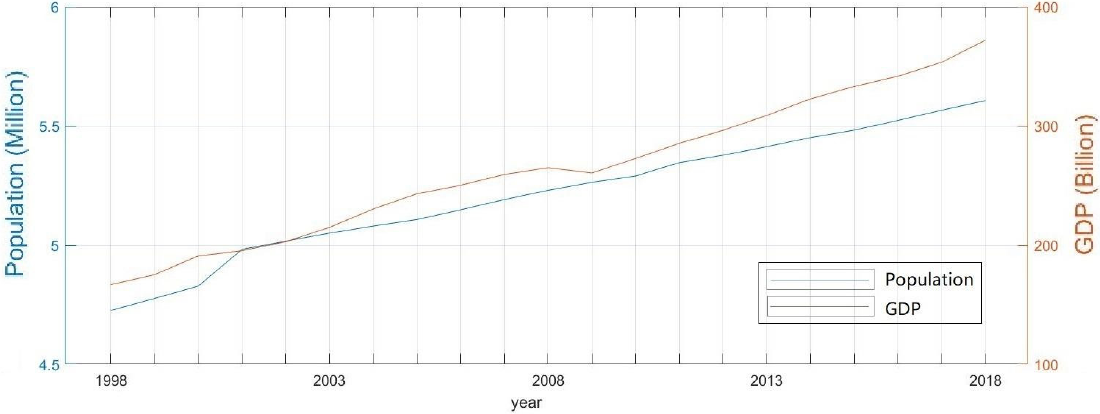
Figure 5. The trend of population and gross domestic product (GDP) growth in the state of Minnesota.